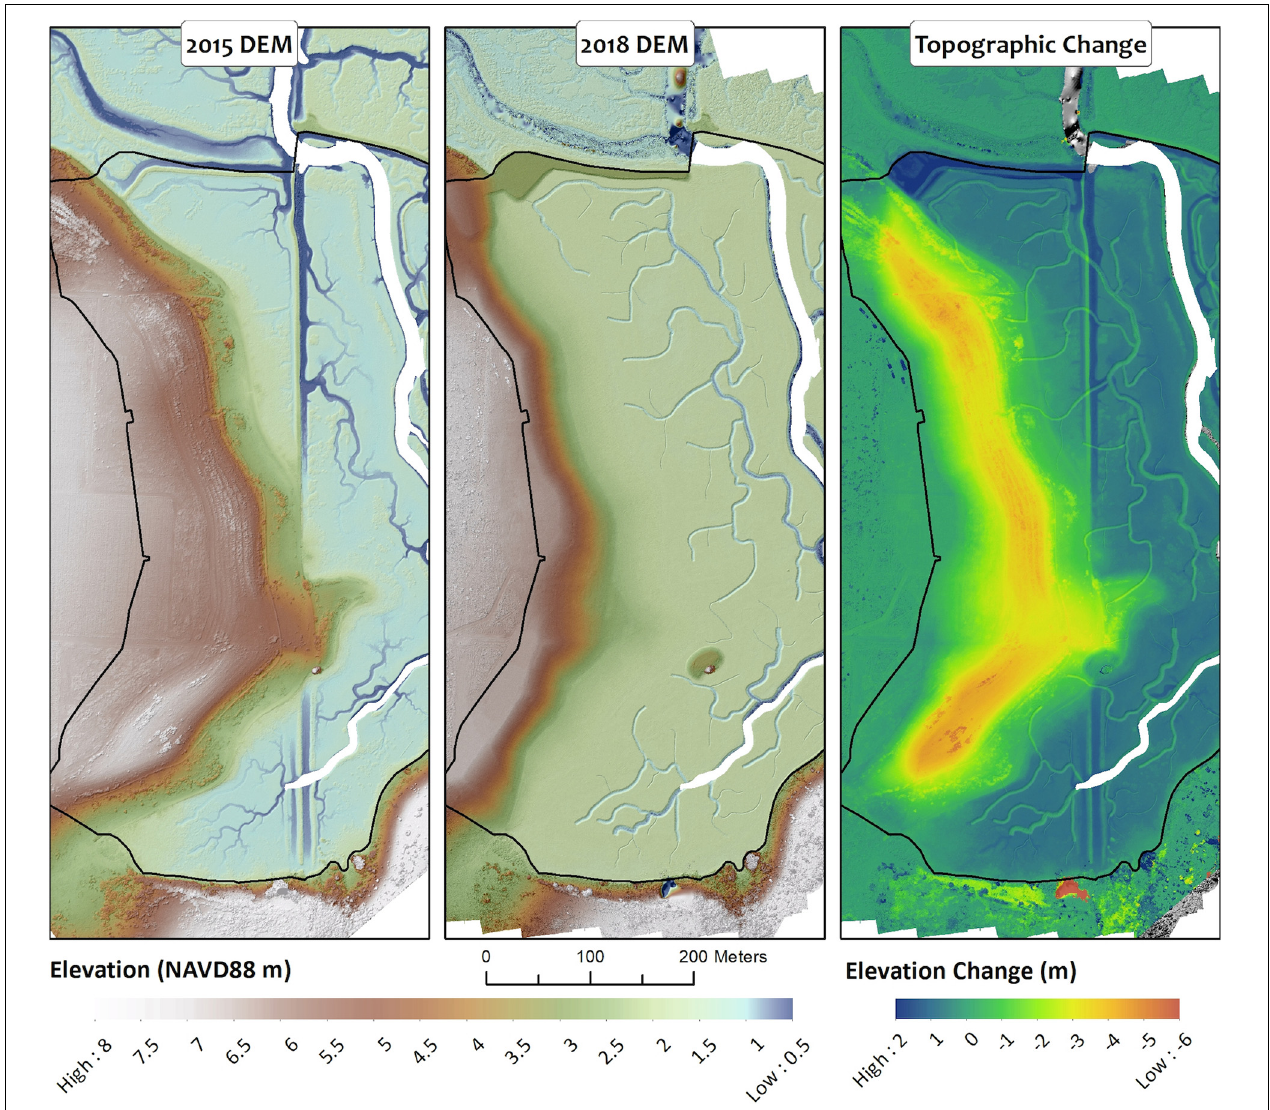
FIGURE 7 | Maps showing elevation change on the western side of the restoration site, where soil was scraped from the hillside to elevate the marsh plain. A DEM of Difference (right) represents topographic change between pre-construction (2015 DEM, left) and post-construction (2018 DEM, middle) and was used to calculate the volume of soil moved from the hillside during